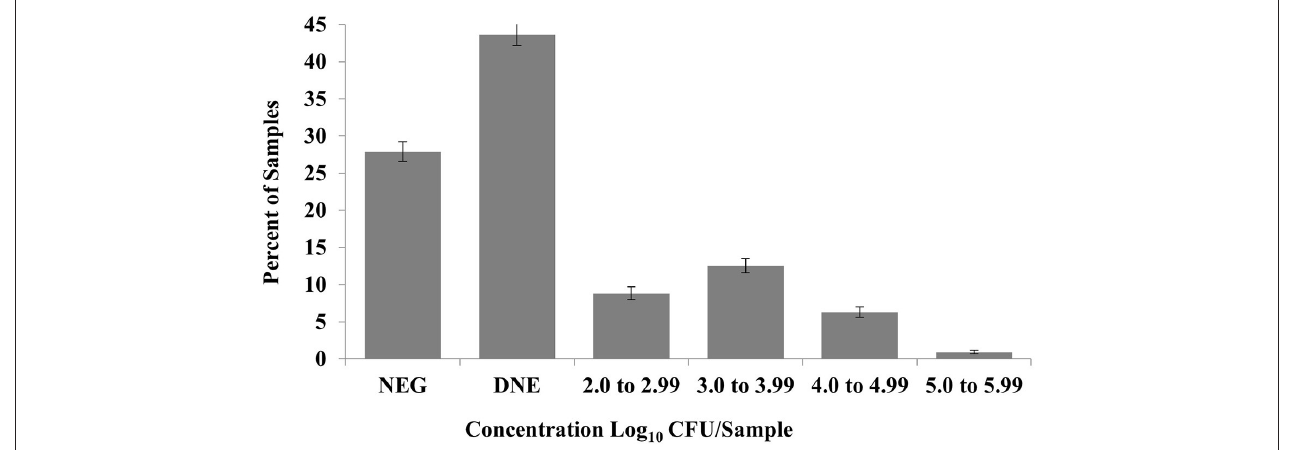
FIGURE 2 | Concentration of Salmonella positive fecal samples by log. NEG, negative following quantitative and qualitative culture; DNE, negative on quantitative culture, positive on qualitative